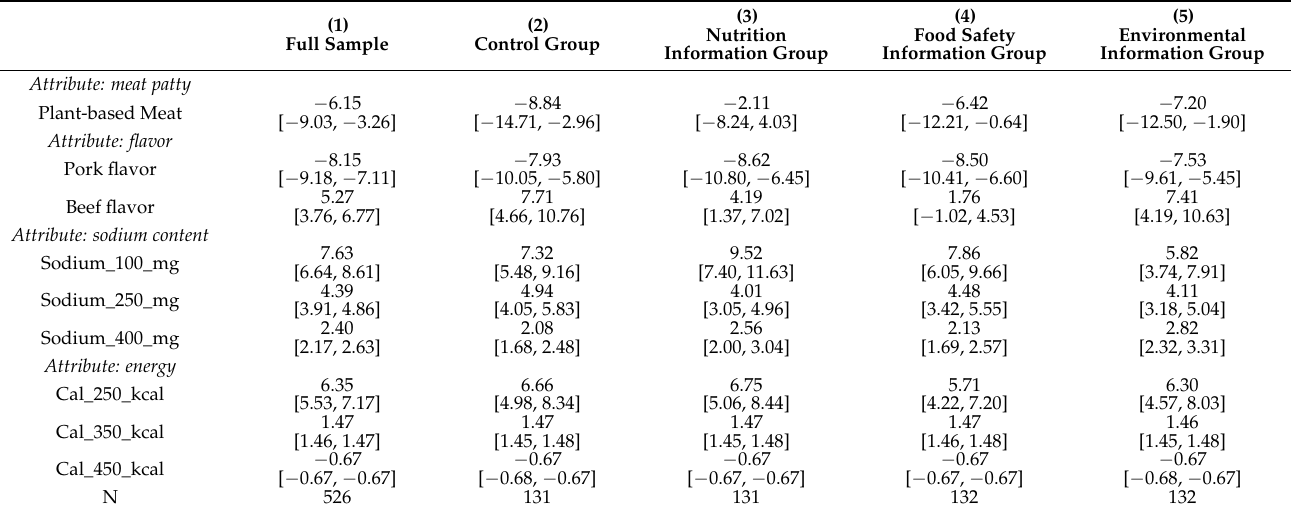
Table 5. WTP estimates for different groups (unit: